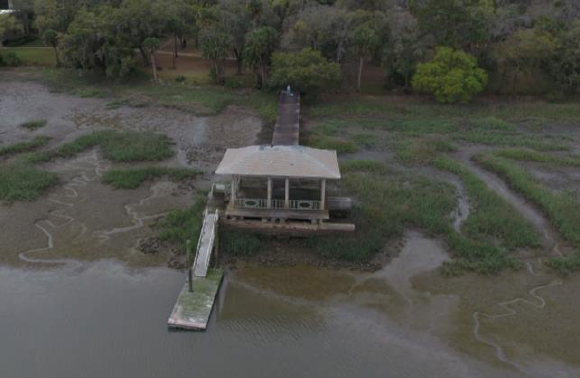
Figure 2. The historic concrete dock at Wormsloe.